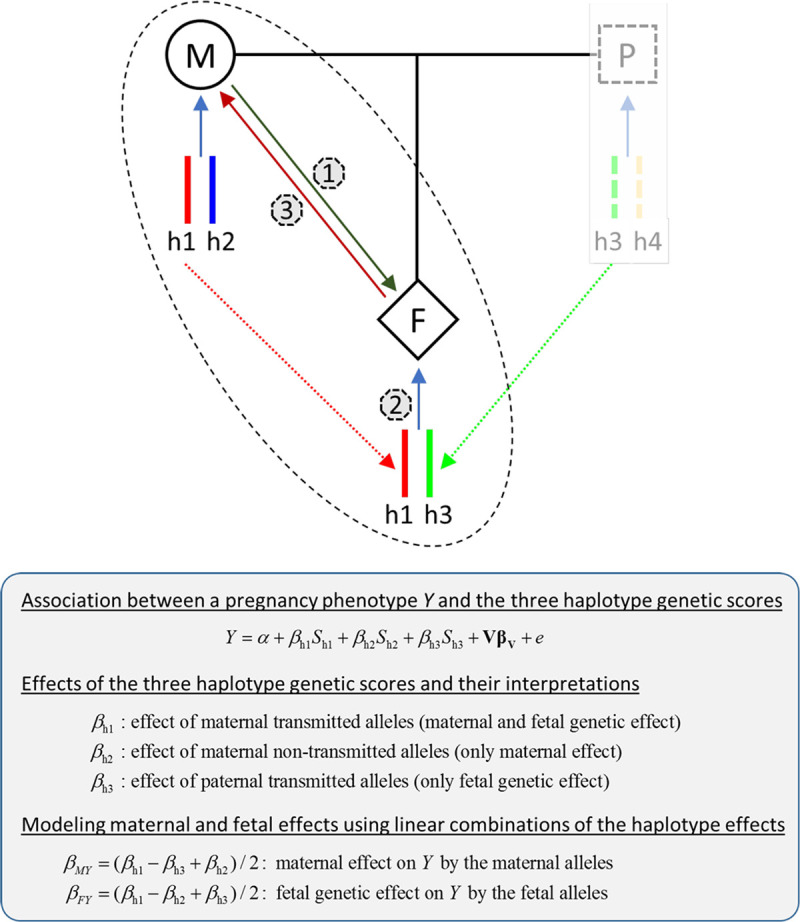
Genetic dissection of maternal and fetal genetic effects using haplotype genetic scores in mother–child pairs.There are 3 groups of alleles (haplotypes) in a mother (M)–fetus (F) duo: the maternal transmitted alleles (h1) can affect a pregnancy outcome through a maternal (1) and/or fetal genetic effect (2), the maternal nontransmitted alleles (h2) can only affect a pregnancy outcome through maternal effect (1), and the paternal transmitted alleles (h3) only through fetal effect (2) (assuming no paternal effect). The paternal transmitted alleles (h3) could influence a maternal phenotype during pregnancy by fetal drive (3). The paternal genetics might be able to influence maternal phenotype and pregnancy outcomes through the environment that the fathers create (i.e., paternal effect or “genetic nurture”). However, for the traits and their associated variants considered in this study (S2 Table), the paternal effects should be minimal and therefore were assumed to be zero.